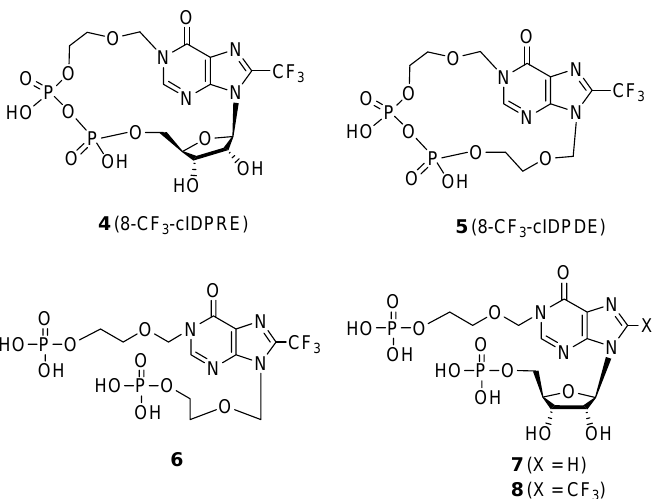
Figure 2. Structures of compounds 4-8